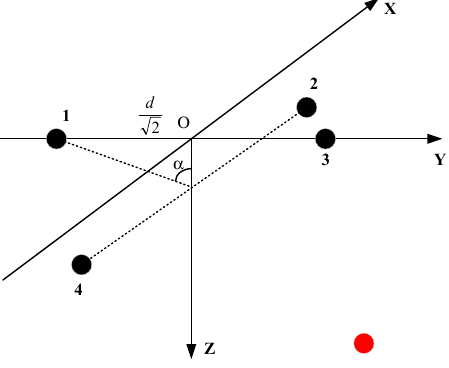
Figure 3. The four-element stereo array 2.